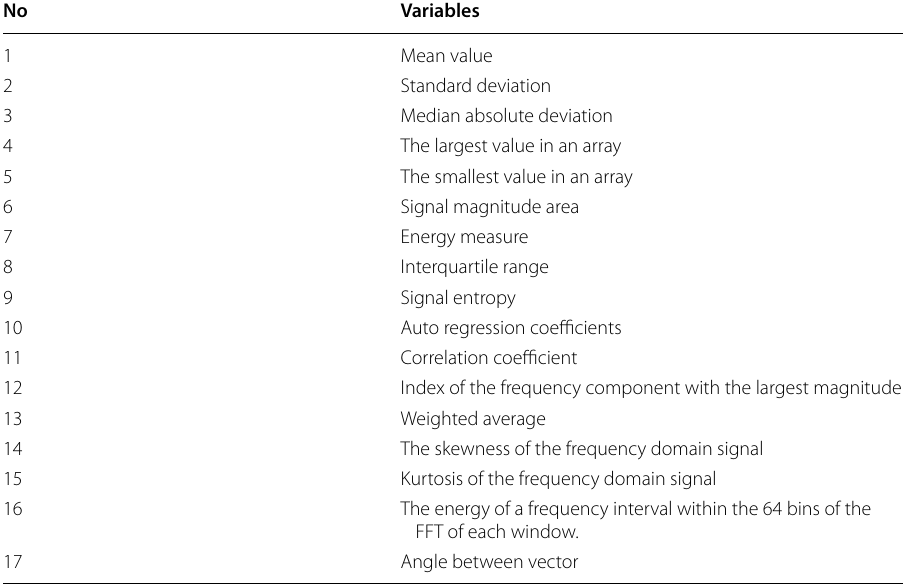
Table 7 Feature description human activity recognition using smartphones dataset (variables from the